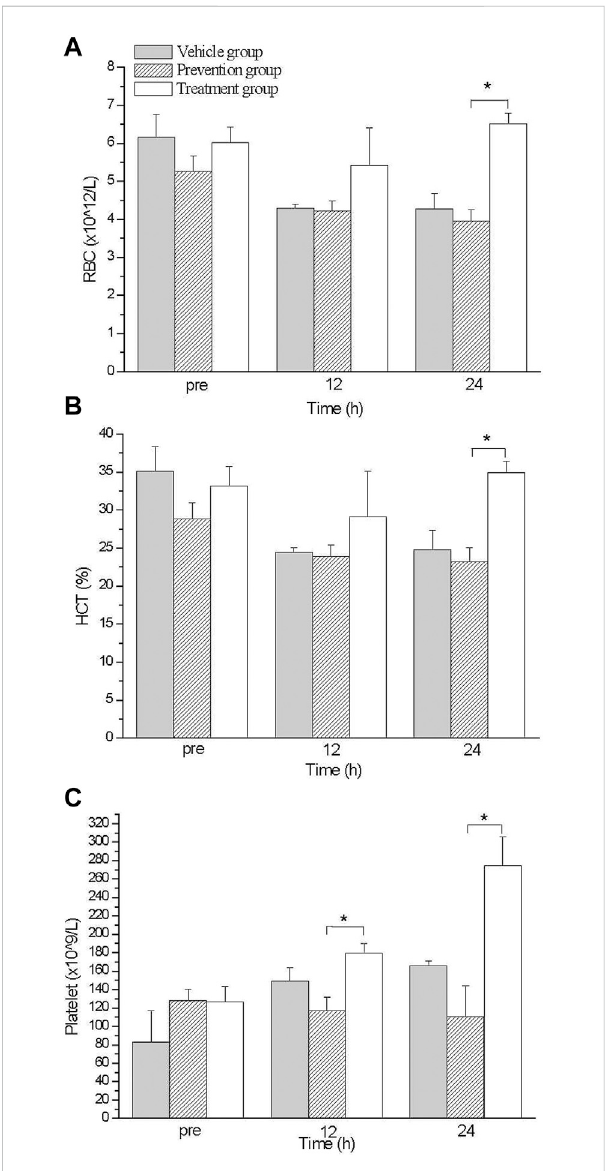
FIGURE 2 The comparison of blood count levels between groups. Treatment group had higher RBC (A) , HCT (B) and PLT (C) values than thoseinpreventiongroupat24 hs.*indicates p -value < 0.05,compare with prevention